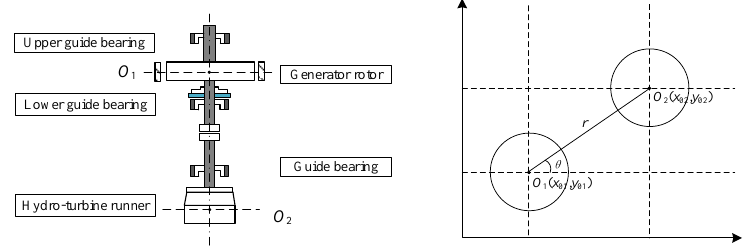
Figure 3. The structure diagram of shafting system. O 1 and O 2 are the centroids for the generator rotor and the hydro-turbine runner, respectively, where O 1 coincides with the origin of the coordi- nates.